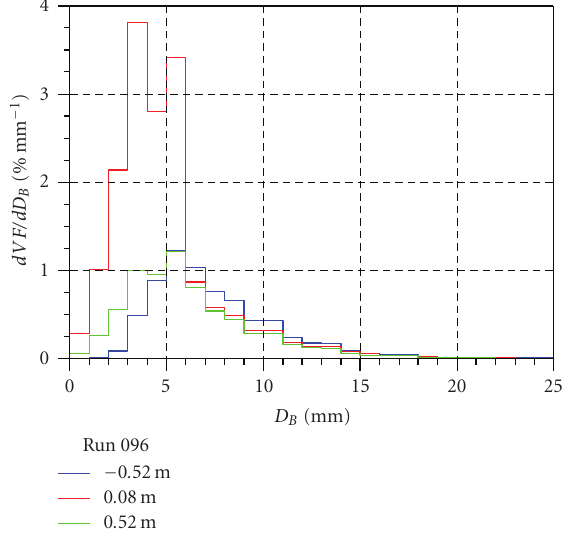
Figure 10: Bubble size distributions for run 097 ( J L = 1 . 611 m/s, J G = 0 . 0898 m/s) (CFX) ( F B = F C = 0 .